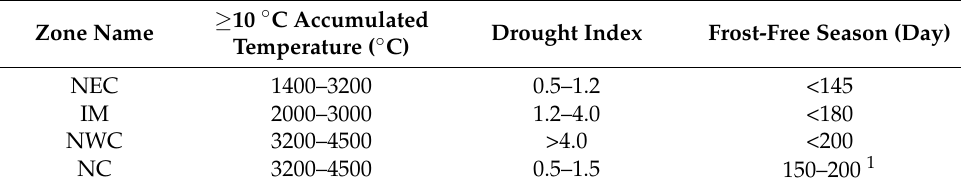
Table 1. Main climatic indicators of the major zones in northern China.